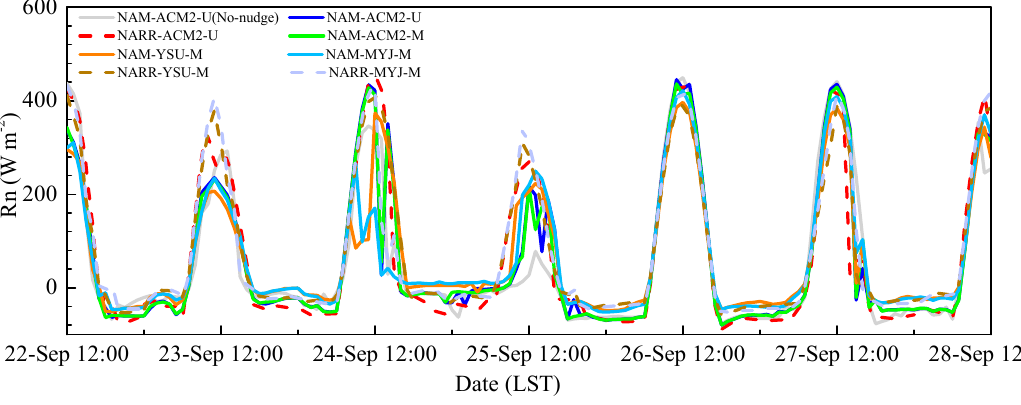
Figure 7. Time variation of WRF simulated Rn over the flux tower site.